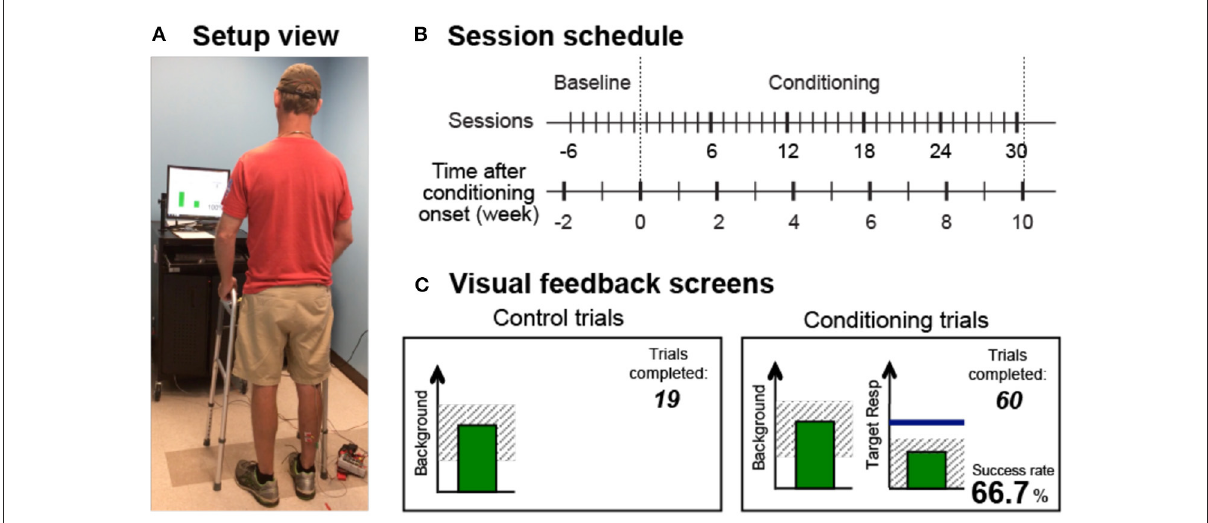
FIGURE1 Reflex conditioning session setup overview. (A) Setup view. Soleus H-reflexes were elicited while the participant maintained a stable standing posture and the soleus and TA muscle activity. (B) Session schedule. Each participant was exposed to six baseline sessions and 30 conditioning sessions that occurred at a pace of 3 times per week. (C) Visual feedback screens for control and conditioning trials. During all trials, the number of trials completed within its block is displayed, and the background EMG panel shows the correct range (shaded) and the current value (green vertical bar, updated every 200ms). If the soleus EMG stays in the correct range for at least 2s, the tibial nerve is stimulated, and an H-reflex is elicited. In control trials (left), H-reflex size is not shown. In conditioning trials (right), the shading in the Target Response panel indicates the rewarded H-reflex size range for down-conditioning. The dark horizontal line indicates the average H-reflex size for the 6 baseline sessions, and the vertical bar shows the size of the most recent H-reflex trial. If that H-reflex size falls into the shaded area, the bar becomes green, and the trial is a success. If it falls out of the shaded area, the bar is red and the trial is a failure. The running success rate for the current block is also